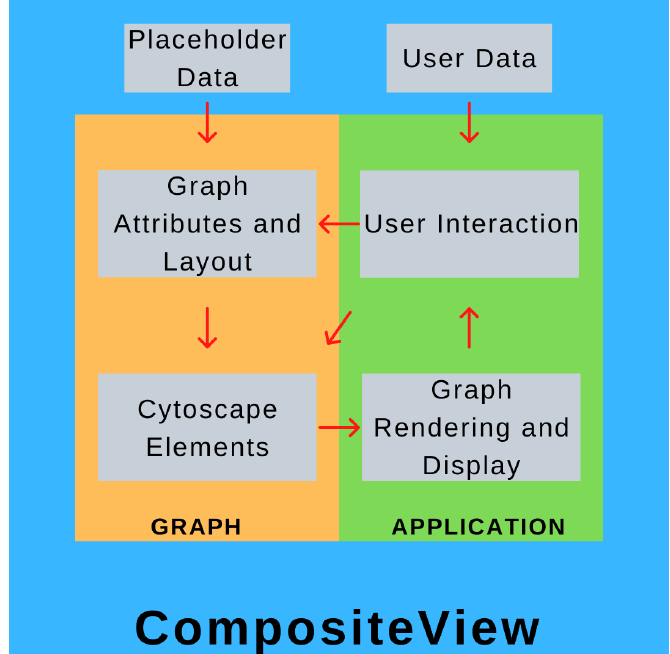
Figure 1. A high-level overview of CompositeView’s working cycle. CompositeView has placeholder data, which initialize the graph, and user data, which initialize the user interaction and application of CompositeView. The cycle begins with a user uploading data and interacting with the application to update the graph attributes and layout. Next, the Cytoscape elements are updated to run the graph. Finally, the graph rendering and display are visually updated to the user in the CompositeView application. The working cycle continues as the user makes updates to the data or changes or applies CompositeView application features such as graph layout selection or filtering